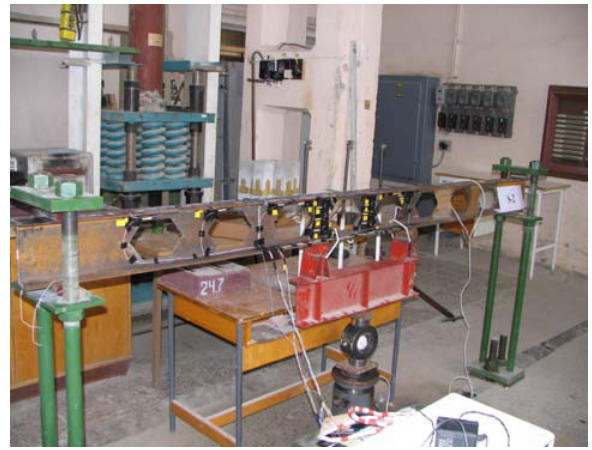
Fig. 1. View on test specimen of plate girder with web